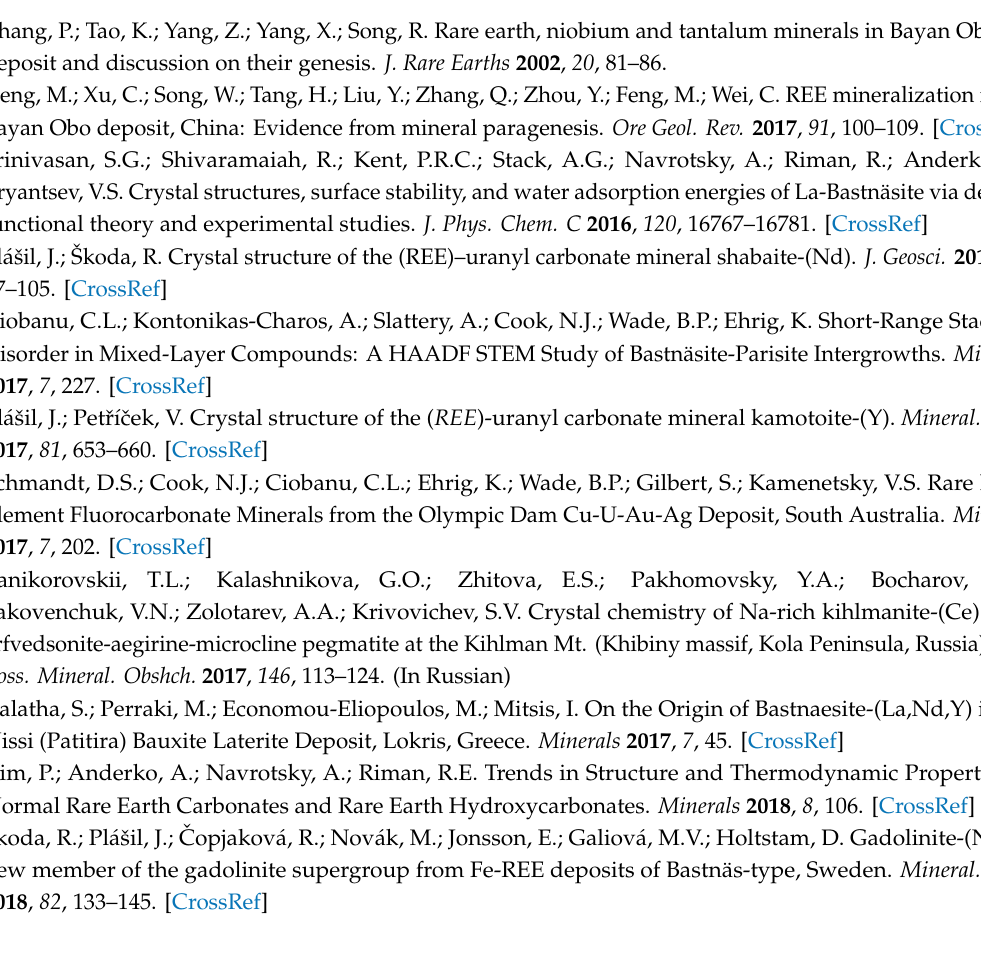
* Crystallographic axes interchanged for the ease of